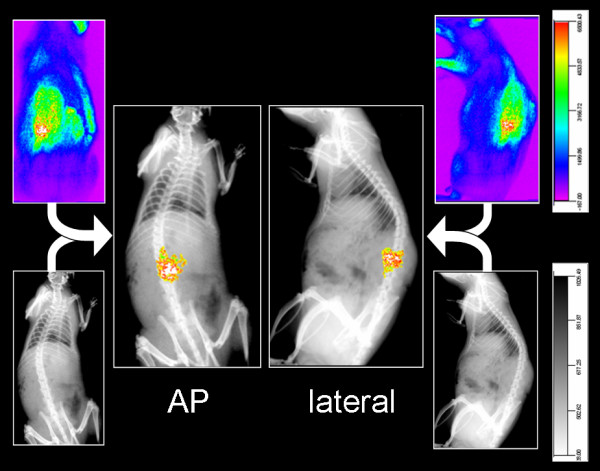
Representative optical and X-ray images with subsequent fusion of a rat at 7 days post surgery, 10 min after injection of 10 mg/kg ICG, AP and lateral view. In order to visualize the areas with the highest fluorescence after injection of the contrast agent fusion was performed by fusing all signal intensities above 6000 units on the OI image. Thus, the areas of highest fluorescence are visible on the fused image.